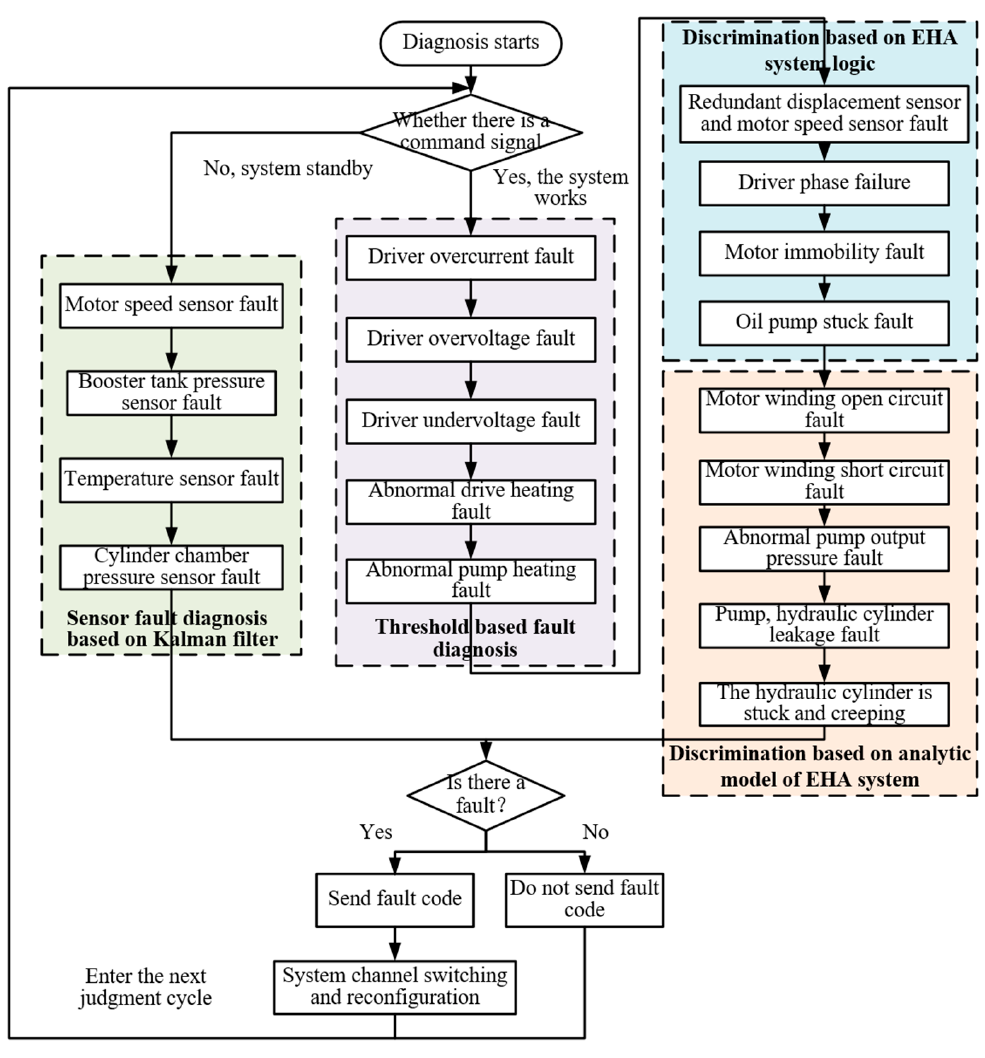
Figure 14. PFDM composition architecture.